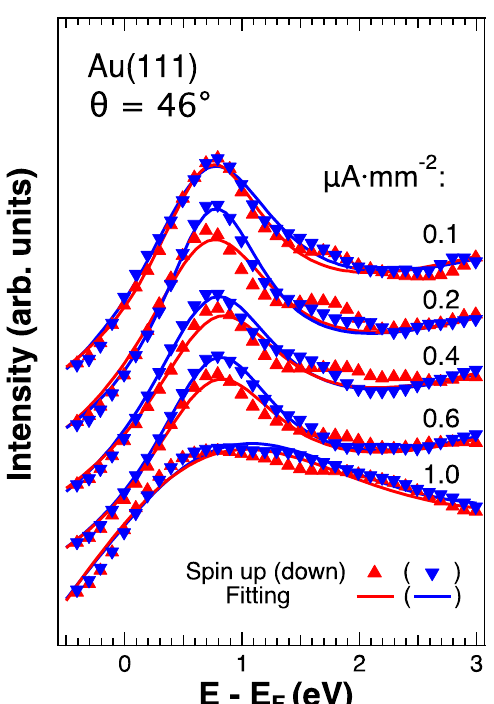
Fig. 3. SPIPES spectra of Au(111) sp- bulk state ( q = 46°) as a function of the current density over the sample. The data (triangles) are normalized to maximum intensity and fitting lines are shown. The effects of the current density are observed in: (i) the spin asymmetry and (ii) the spectral broadening of the